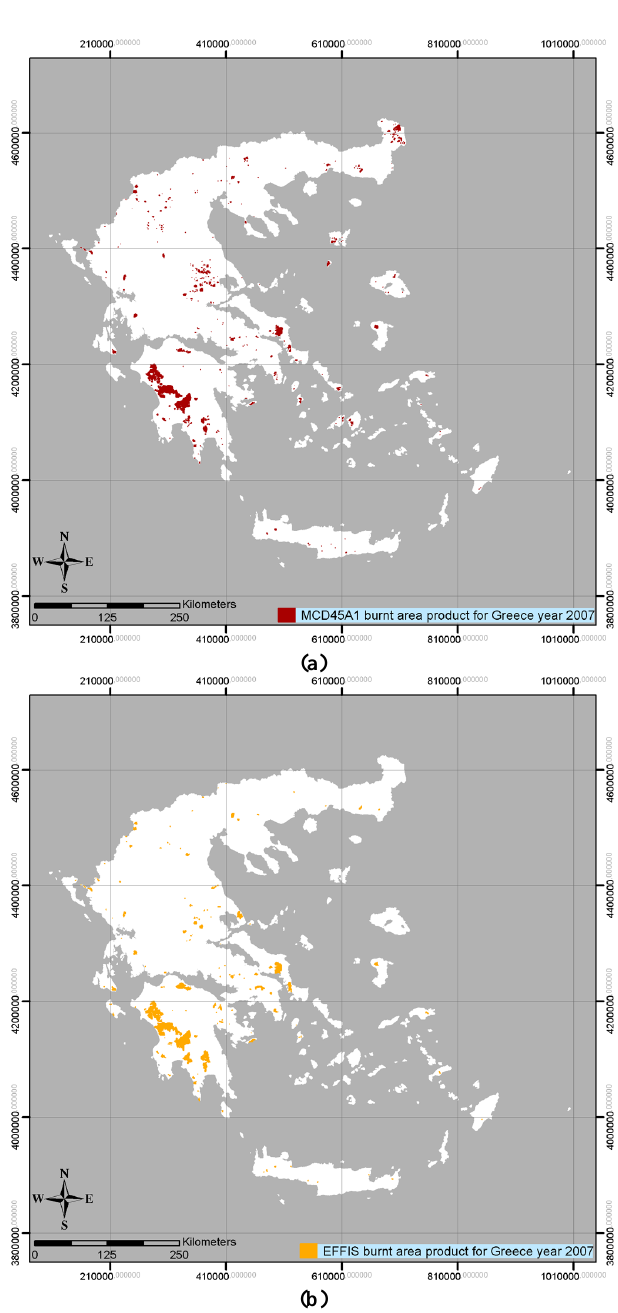
Fig. 2. Examples of final burnt area products derived derived from the (a) MCD45A1 and (b) EFFIS for the year 2007 after the pre- processing